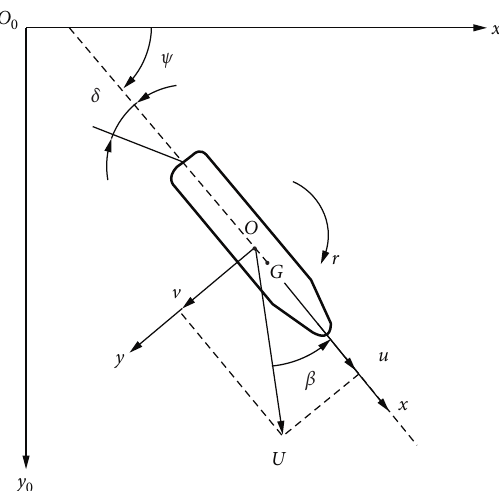
Figure 10: Reference system adopted for the